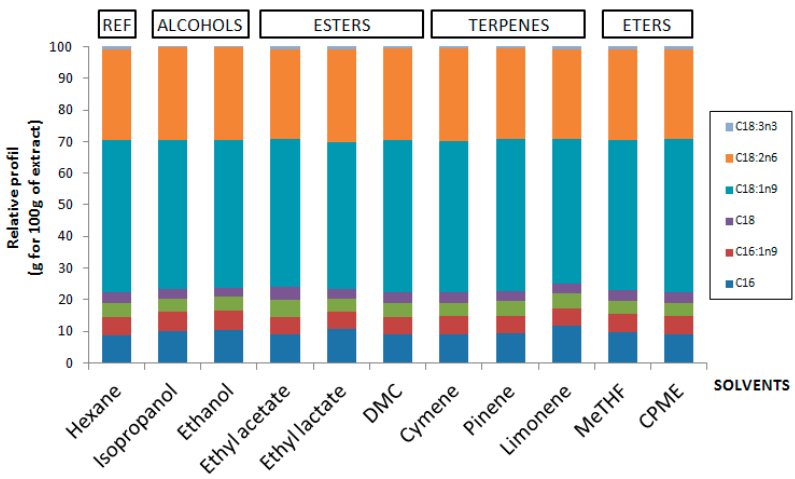
Figure 3. Comparison of the distribution of fatty acids by GC-FID to determinate if there exists a selectivity during extraction.